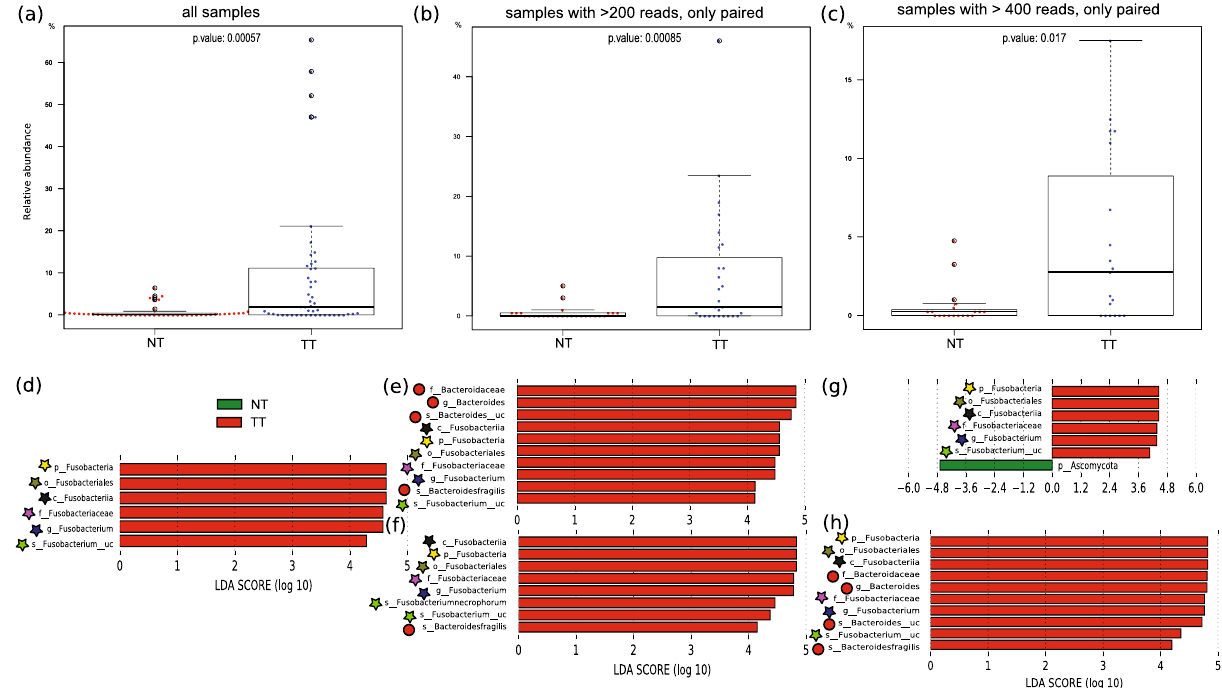
Figure 3. Discriminant taxa between tumors and normal mucosa. (Top) Boxplots of Wilcoxon Signed Rank tests for paired samples for Fusobacterium genus (top) showing statistically significant differences between normal mucosa tissue (NT) and tumor tissue (TT), for three sets of reads: all reads without normalization ( a ), paired-only samples with more than 200 ( b ) and 400 ( c ) reads. (Bottom) Linear Discriminant Analysis (LDA) Effect Size (LEfSe) plot of taxonomic biomarkers identified in the FFPE tissue microbiome from five sets of reads: all reads without normalization ( d ), paired-only samples with more than 200 reads ( e ), paired plus unpaired samples with more than 200 reads ( f ), paired-only samples with more than 400 reads ( g ), and paired plus unpaired samples with more than 400 reads ( h ). Stars indicate Fusobacterium lineage, circles indicate Bacteroides